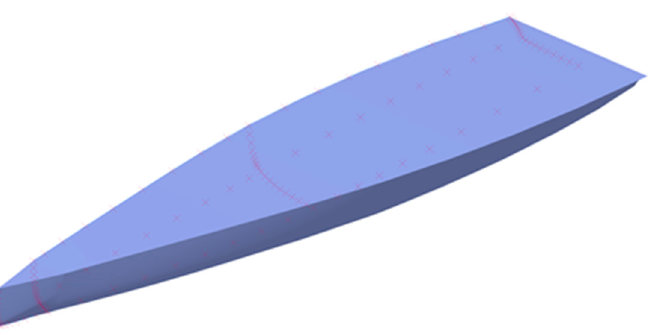
Figure 11. Surface model of a sailboat designed in CREO 4.0 with the information from the VBA tool.